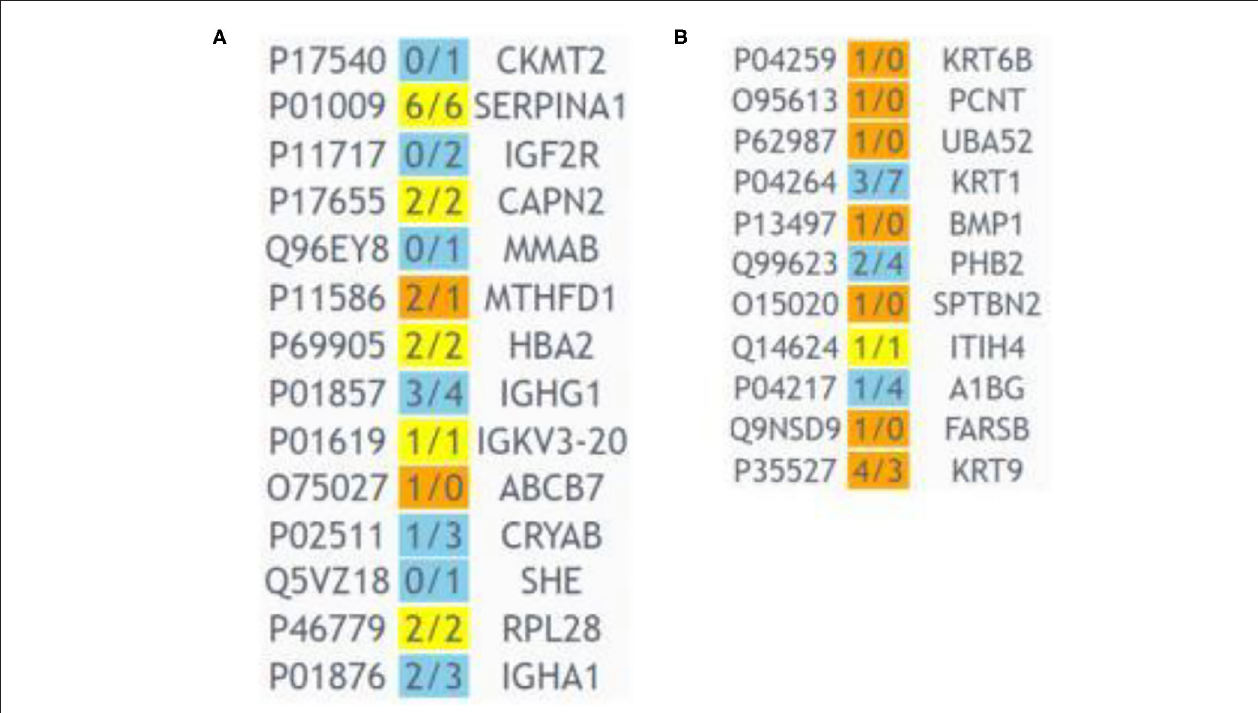
FIGURE 9 | Heat map generated by dbDEPC 3.0 (14) from exosomal proteins from BCP blood, associated with breast cancer. (A) Proteins from plasma exosomes, (B) proteins from blood cell-surface-associated exosomes. Orange means that the number of the studies identified this protein as up-regulated is more than the number of the studies identified the protein as down-regulated; blue means that the number of the studies identified this protein as up-regulated is less than the number of the studies identified protein as down-regulated; yellow means that the number of the studies identified the protein as up-regulated is equal to the number of the studies identified protein as